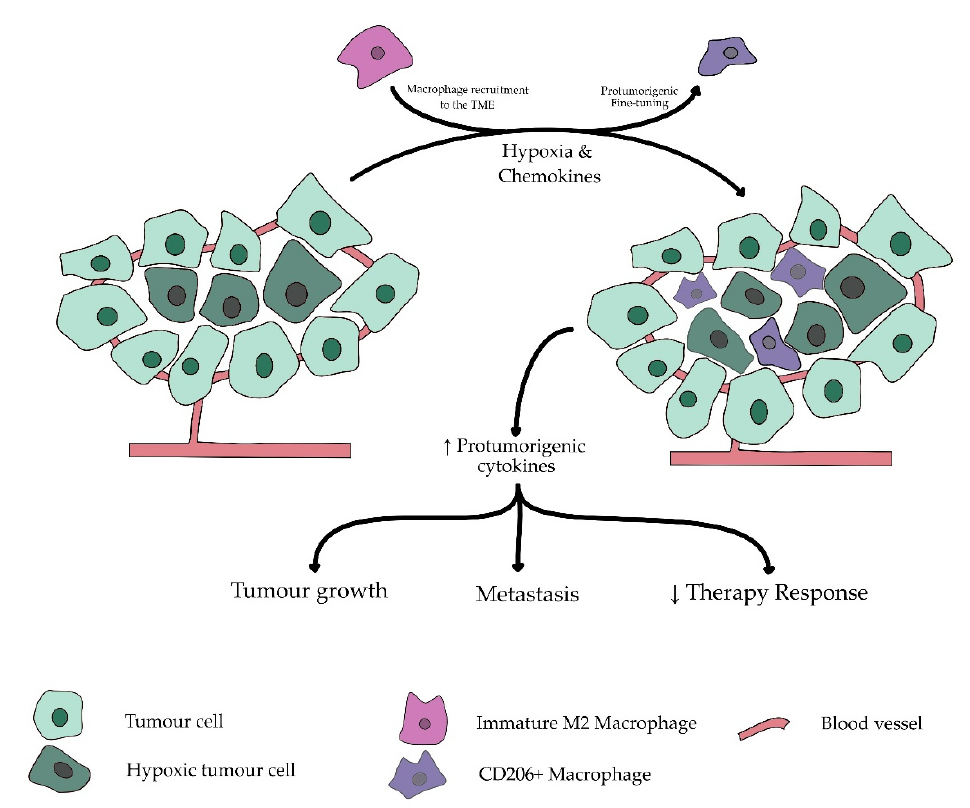
Figure 2. Simplified overview of the role of CD206+ macrophages in hypoxia-induced tumor progression. Tumor growth and insufficient coexpanding blood vessels often result in hypoxic regions in solid malignancies. In these hypoxic regions, a switch is made to anaerobic glycolysis, inducing production of inflammatory metabolic lactates. Consequential increased inflammation attracts macrophages to tumor microenvironment by differentiating circulating monocytes to macrophages and attracting tissue resident macrophages. Under influence of hypoxic environment, these macrophages are further fine-tuned by multiple chemokines developed by tumor cells and its microenvironment to suppress local inflammation and decrease attraction of antitumorigenic immune cells while developing additional protumorigenic cytokines. These protumorigenic effects result in an increased risk for metastasis, decreased therapy response, and further enhance tumor growth.